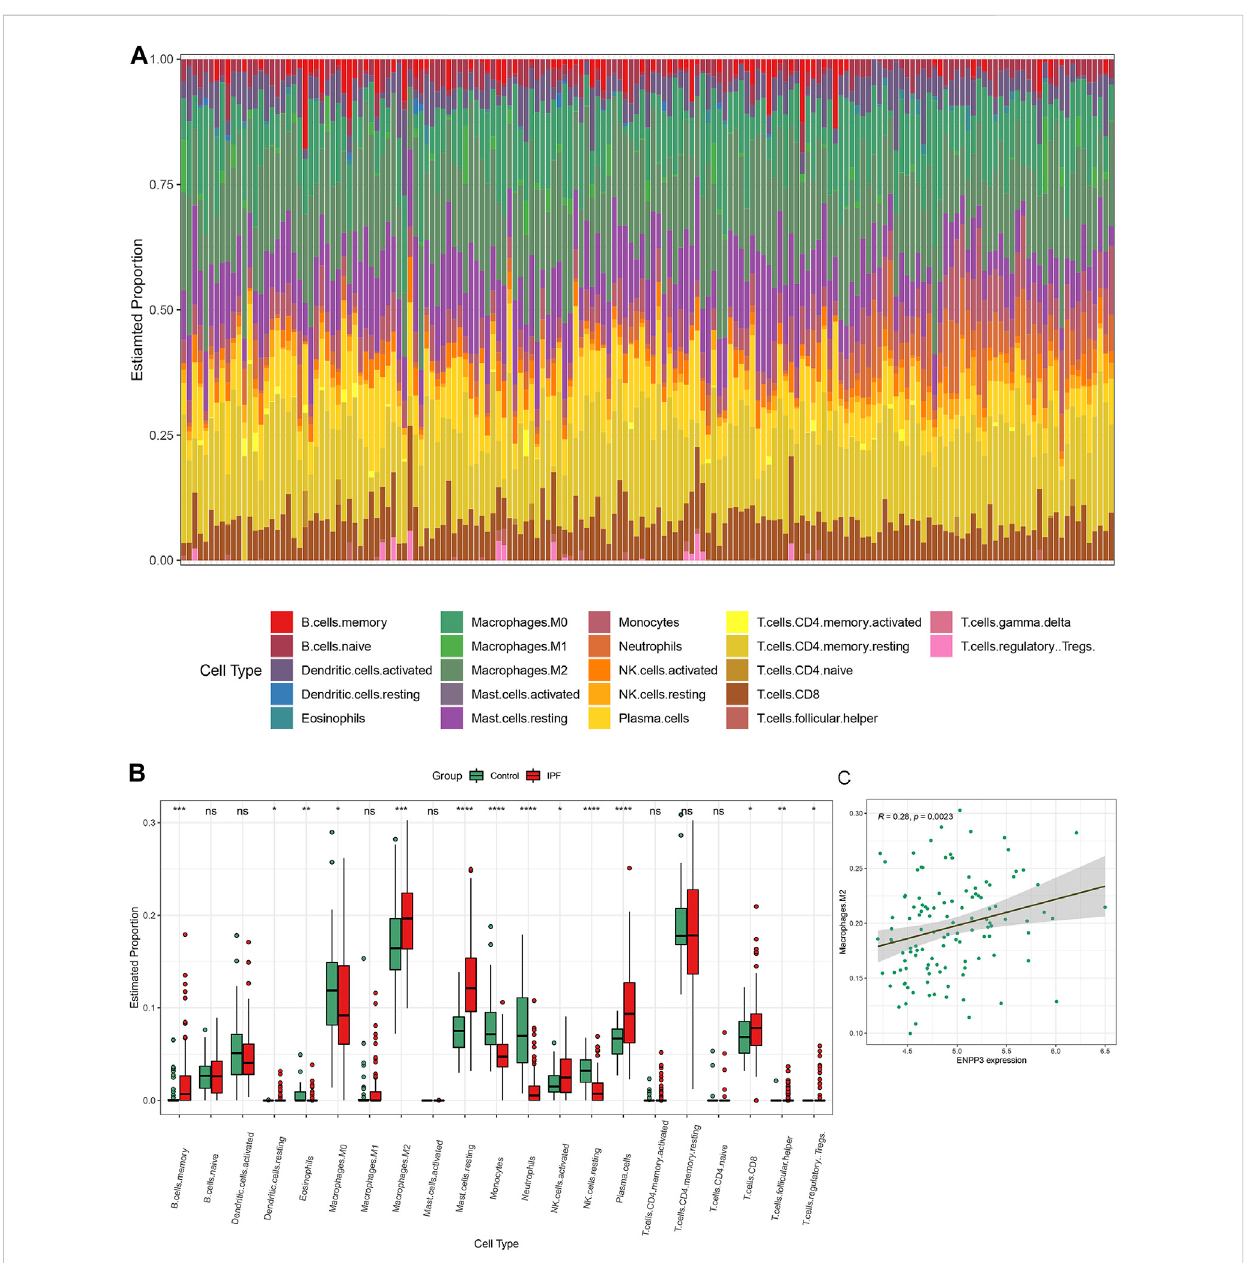
FIGURE 6 Immunecellin fi ltrationinIPF. (A) Histogramoftheproportionofeachtypeofimmunecellinthelungtissueof119IPFpatientsand50controlsinthe GSE32537 dataset. (B) Boxplot oftherelativeexpressionofeachimmune cellsubtype between theIPFpatients andhealthycontrols. (C) M2macrophage expression was positively correlated with the expression level of ENPP3. * p < 0.05; ** p < 0.01; *** p < 0.001; **** p <